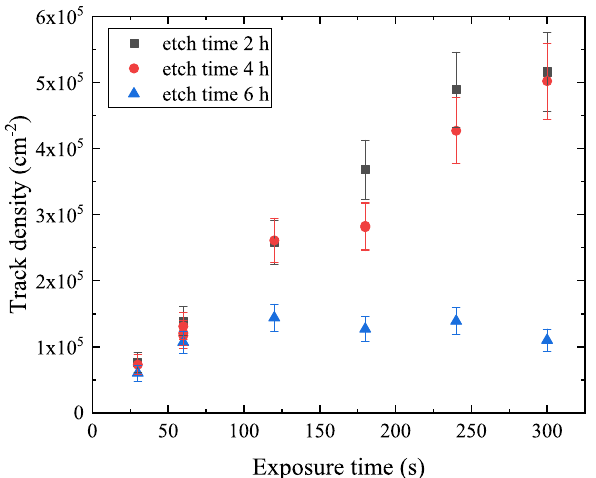
Figure 5. Alpha particle track density dependence on the exposure time at different etching